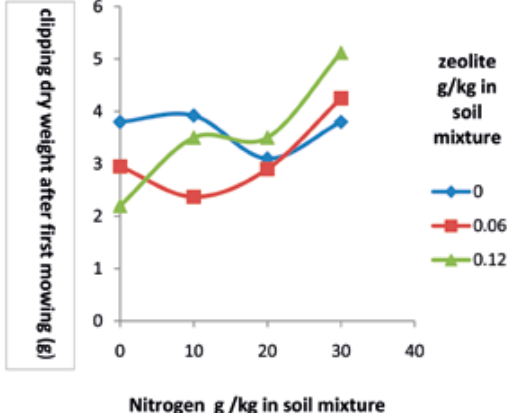
Fig. 2 - Effect of nitrogen and zeolite on clipping dry weight after first mowing (g) of Festuca arundinaceae Schreb‘Starlet’.